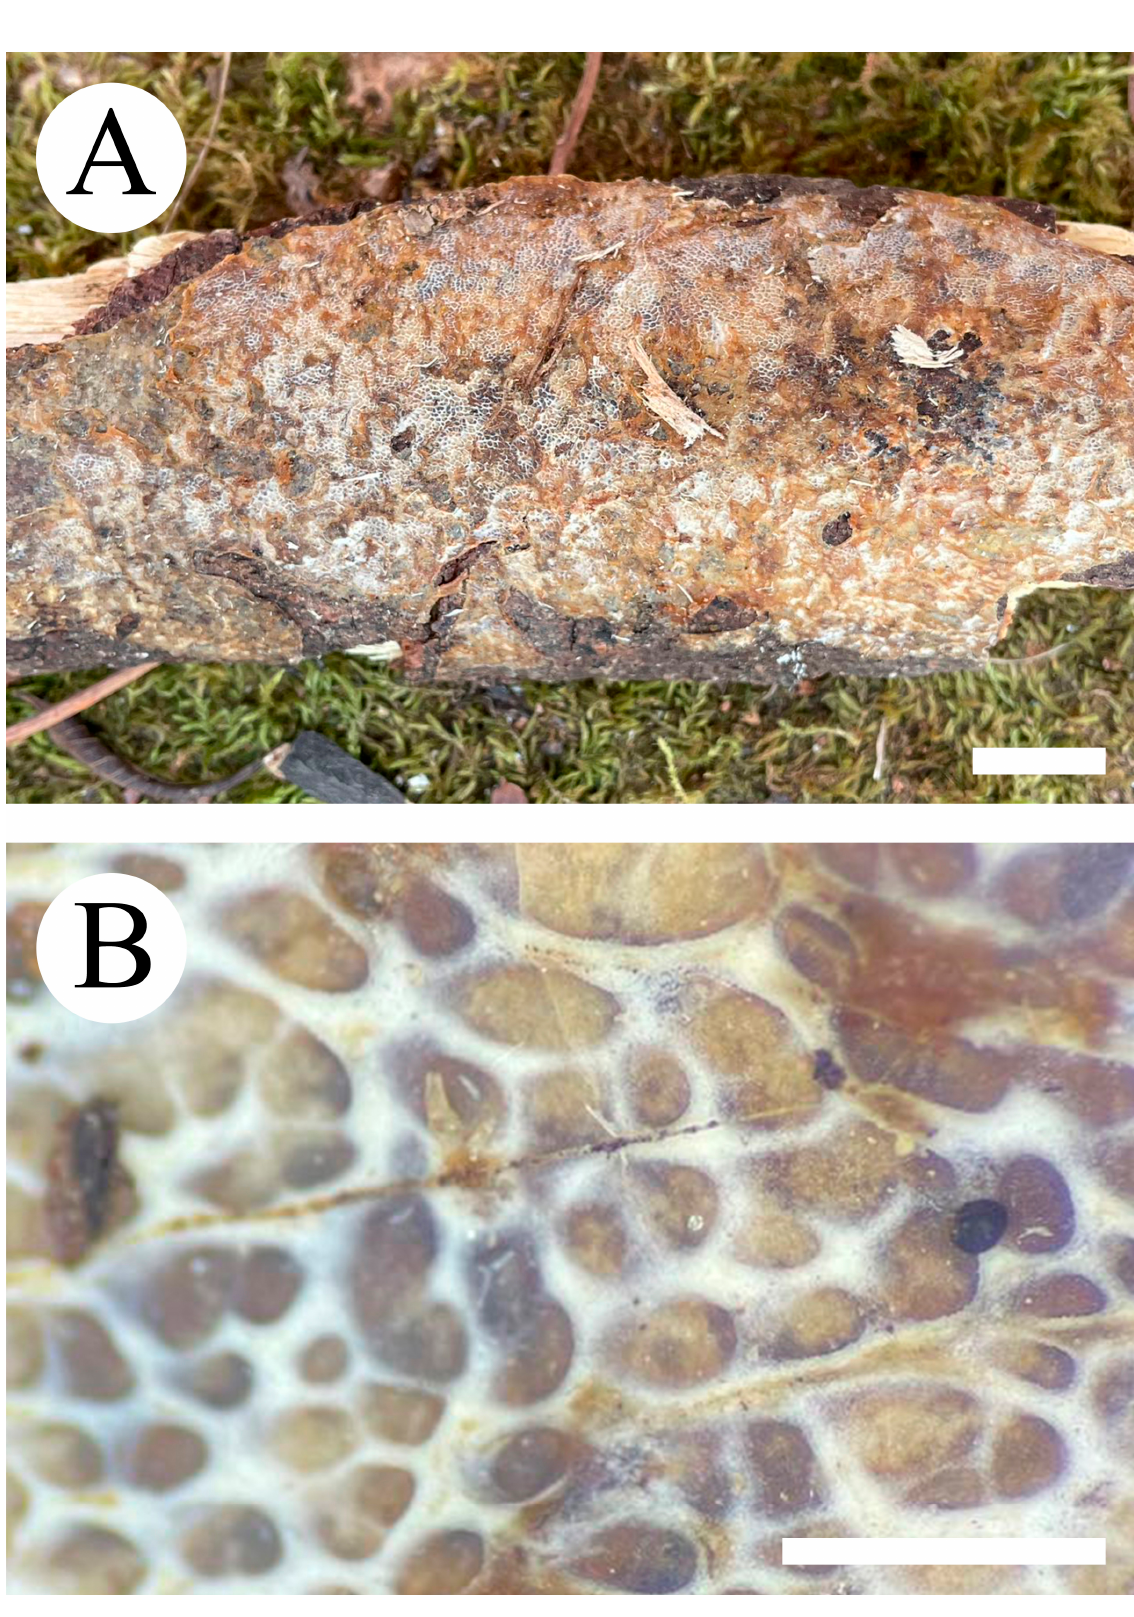
Figure 15. Basidioma of Phlebia poroides (CLZhao 16121, holotype). Bars: ( A ) = 1 cm, ( B ) = 1 mm.